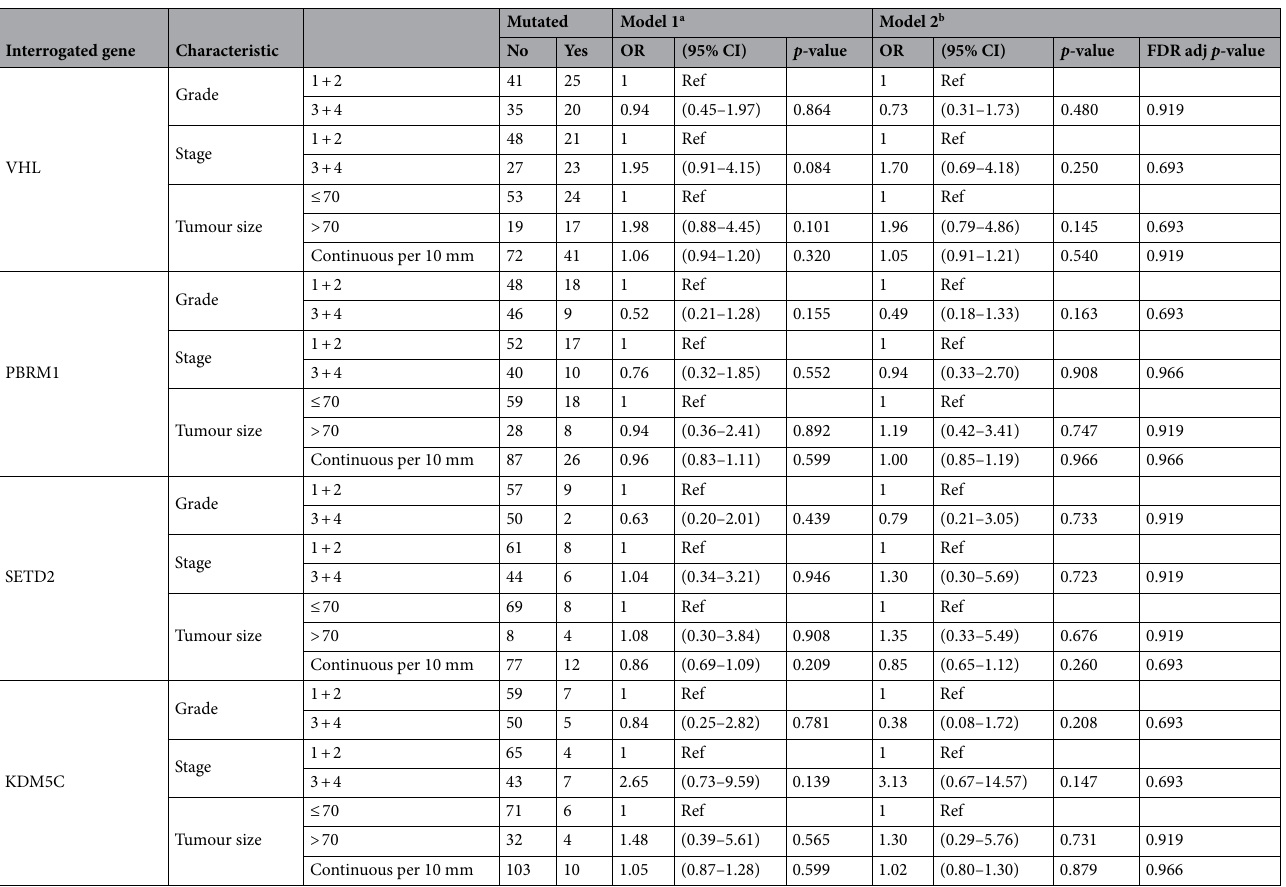
Table 2. Logistic regression models on the association between mutated genes and clinical characteristics. The FDR-adjusted p -value was calculated using the Benjamini–Hochberg method. The cut-off for a